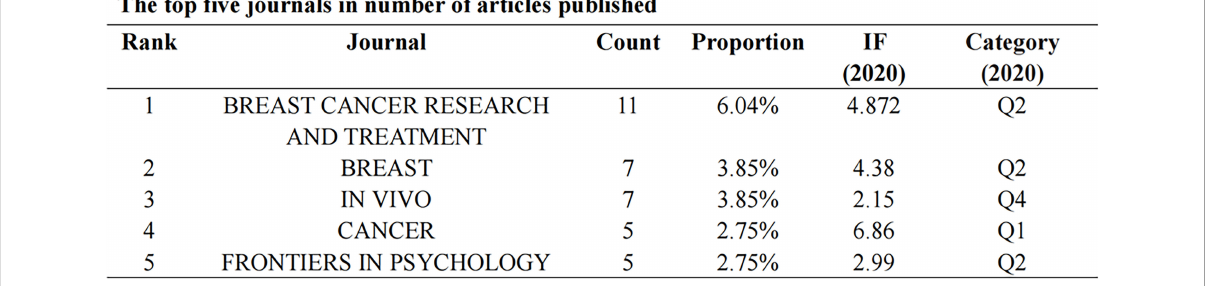
FIGURE 5 The top fi ve journals in number of articles published.